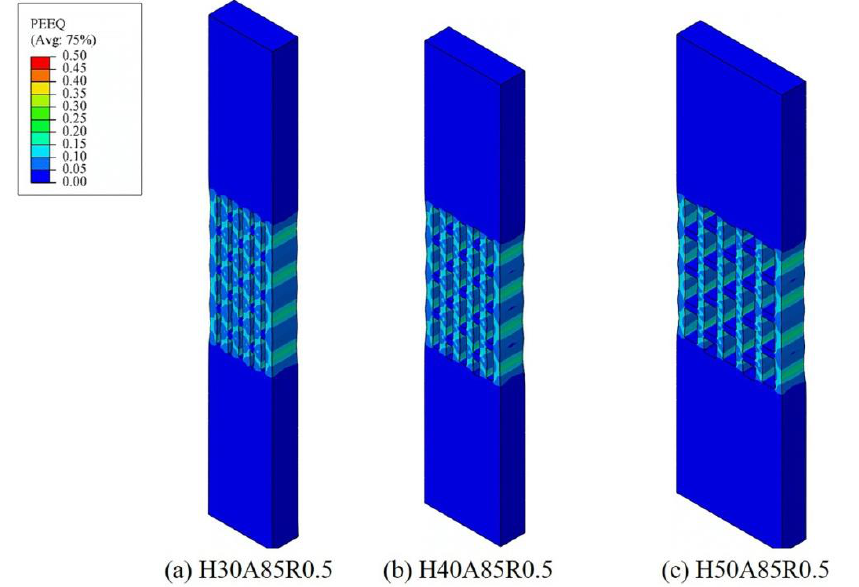
Appl. Sci. 2020 , 10 , x FOR PEER REVIEW Figure 10. Effect of hole ratio on stress triaxiality with ( a ) H30A85R0.5 ( b ) H40A85R0.5 and ( c ) H50A85R0.5. Figure 10. Effect of hole ratio on stress triaxiality with (a)H30A85R0.5 (b)H40A85R0.5 and